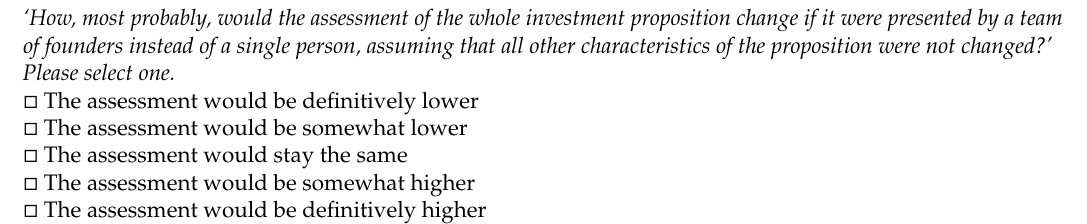
Table 5. Assessment of the importance of the team and the preferred composition of the